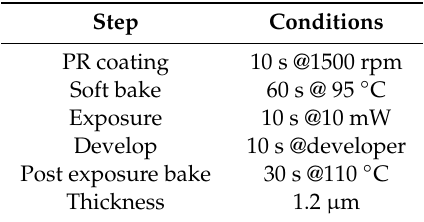
Table 1. Photoresist etch mask process conditions.